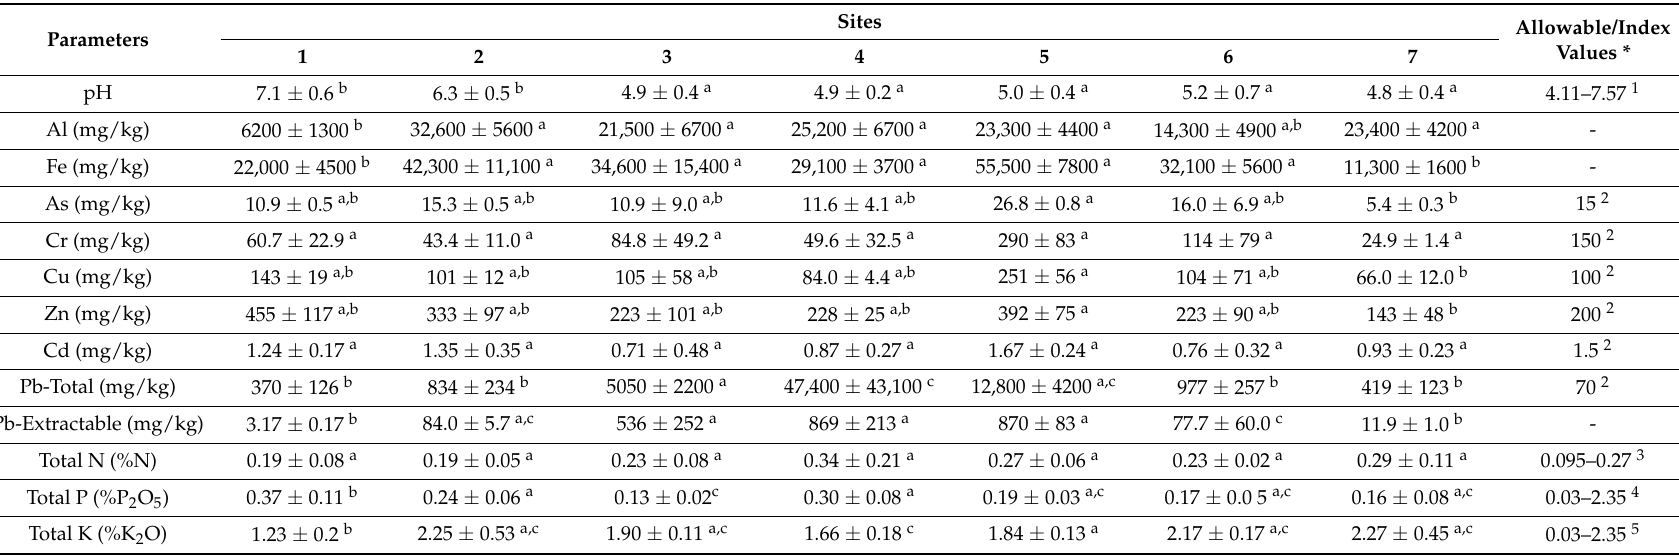
Table 2. pH values and contents of N, P, K, Al, As, and heavy metals in soils in the Dong Mai lead recycling